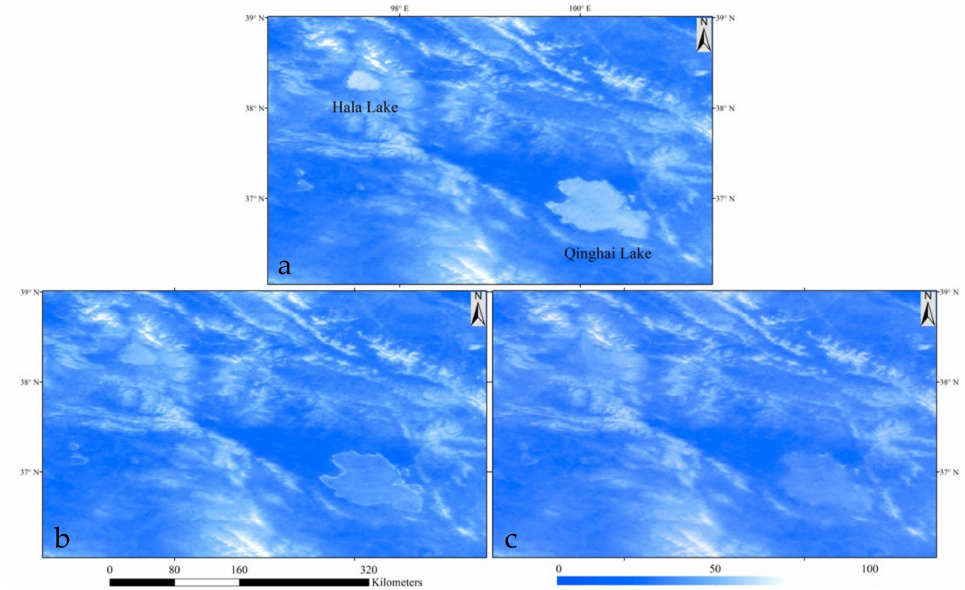
Figure 13. Cloud frequency (%) of Qinghai Lake and Hala Lake in GLHCC01. ( a ) Cloud frequency based on the uncorrected MOD09 cloud mask; ( b ) cloud frequency based on the corrected MOD09 cloud mask; ( c ) cloud frequency after the removal of the albedo